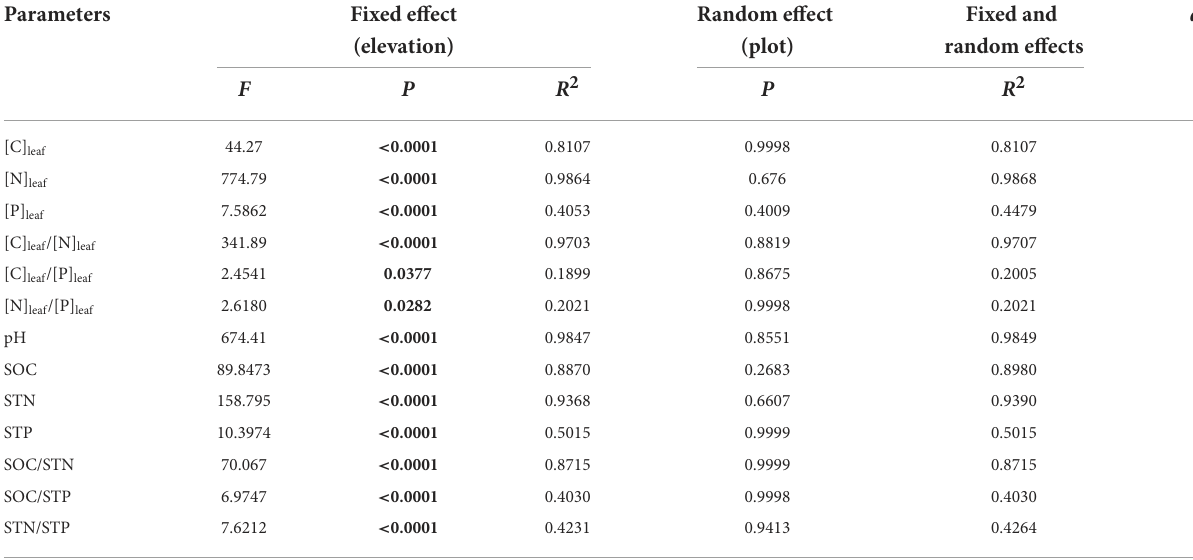
TABLE 2 Summary of the generalized linear mixed models for leaf stoichiometry and soil properties (0–0.40m) ( n = 9).